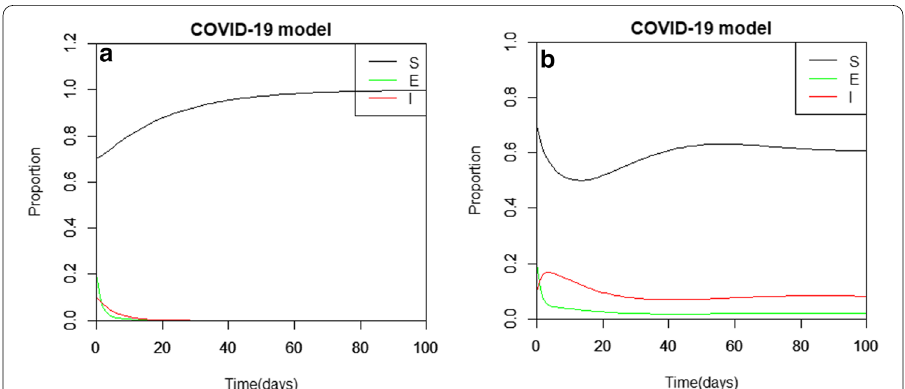
Fig. 2 The latent infection SEIR model asymptotic stability analyses